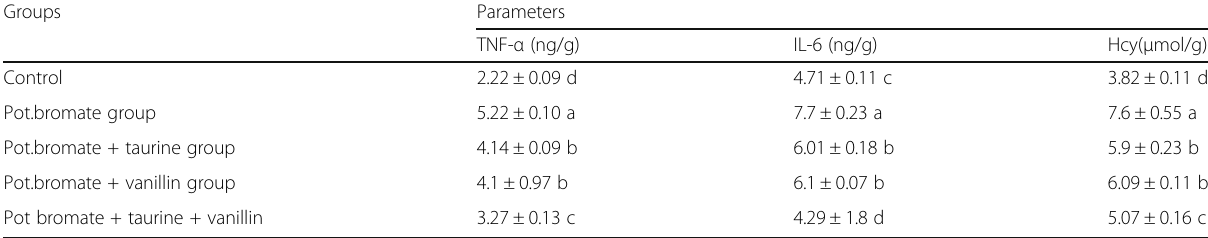
Table 4 Effect of taurine and/or vanillin on tumor necrosis factor- α (TNF- α ), interleukins-6 (IL-6), homocysteine (Hcy), and malondialdehyde (MDA) in kidney of the potassium bromate-treated rats Groups